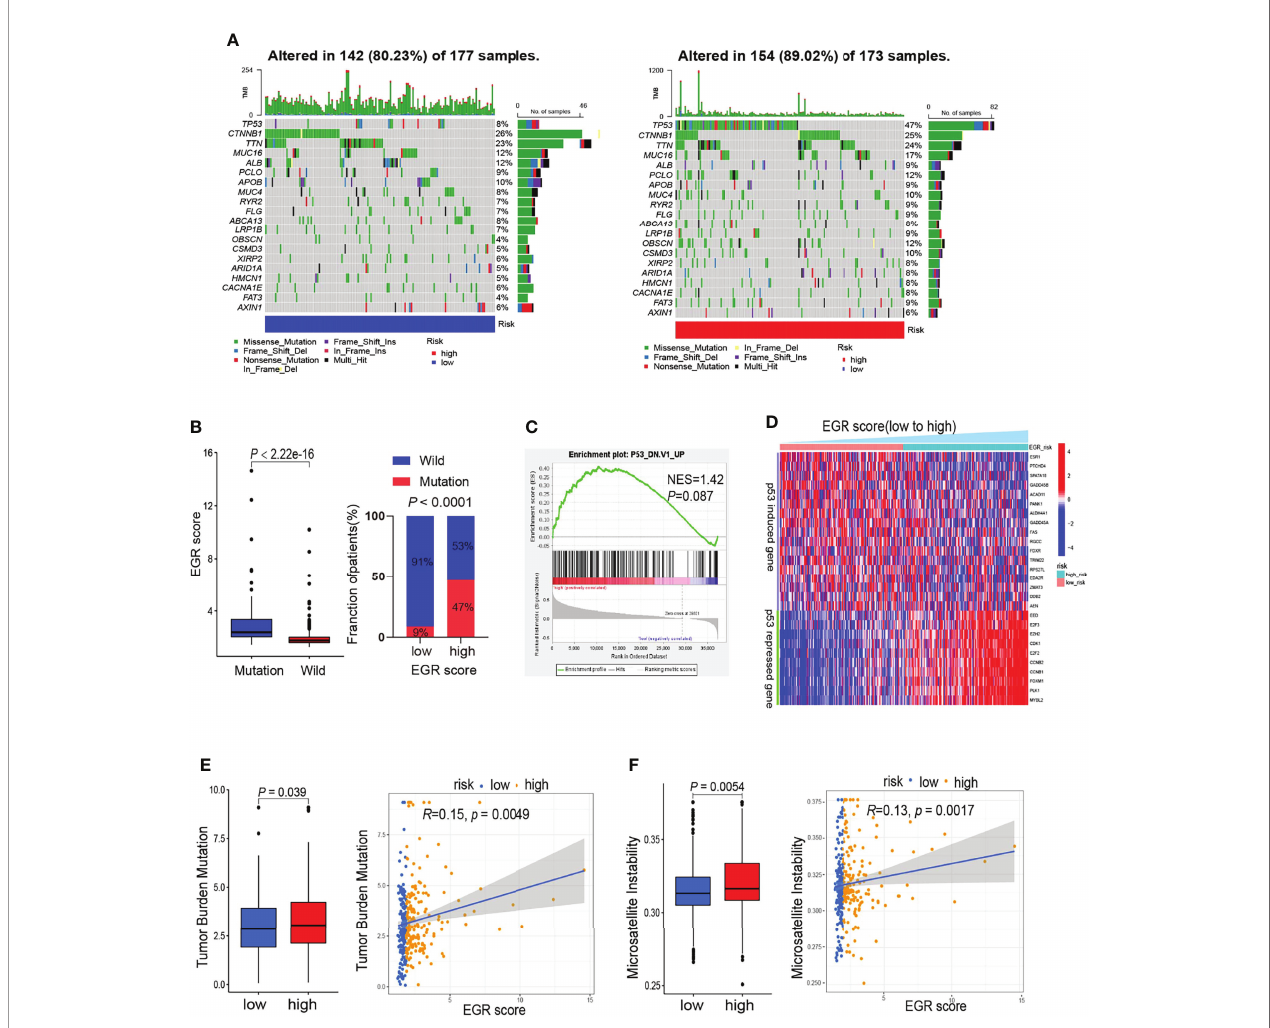
FIGURE 3 | Comparison of mutation landscape between EGRscore-low and EGRscore-high tumors. (A) Waterfall maps between EGRscore-low and EGRscore-high HCC patients. (B) Proportion of the m6Ascore-high and m6Ascore-low group in patients that harbored wild-type or mutant TP53. (C) GSEA of genes upregulated in the NCI-60 panel of cell lines with mutated TP53. (D) Correlation of EGRscore and the expression of p53-induced genes or p53-suppressed genes in HCC patients. (E) Boxplot and correlation analysis of tumor burden mutation and EGRscore. (F) Boxplot and correlation analysis of microsatellite instability and EGRscore. ns, statistically insigni fi